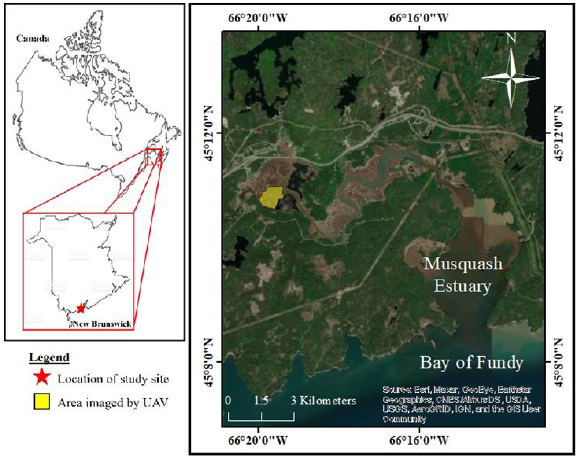
Figure 1. Location of the study area and limits of the area imaged by the UAV imagery over a Google Earth image.